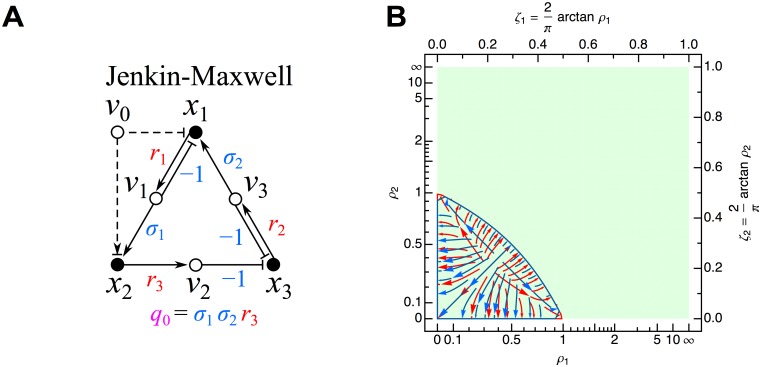
Jenkin-Maxwell network.(A) Influence topology. Cycle compaction allows definition of q
0 = σ
1
σ
2
r
3. Temporal scaling of all Jacobian edges to |q
0| leaves only ρ
1 = r
1/|q
0| and ρ
2 = r
2/|q
0|. (B) Stability phase space. Axes correspond to the two parameters, ρ
1 and ρ
2, that remain after parameter reduction. For plotting ρ
1 and ρ
2, the variable transformation ζi=2πarctanρi has been used to allow visualization of the entire range of the ρ
i from 0 to ∞ (this arctan transform also conveniently permits visualization of the range −∞ < ρ
i < 0, which would correspond to a different sign for this Jacobian element and therefore a different influence topology). Flows in the plot map the zones over which Δ1 (black), Δ2 (red), and Δ3 (blue) are negative. Only Δ2 (red) and Δ3 (blue) can go negative (in this case, simultaneously). The green background indicates that ρ
1 and ρ
2 can independently assume any positive definite values based on their definitions in terms of the parameters used to define the original Jenkin-Maxwell equations (Equations 54–56).